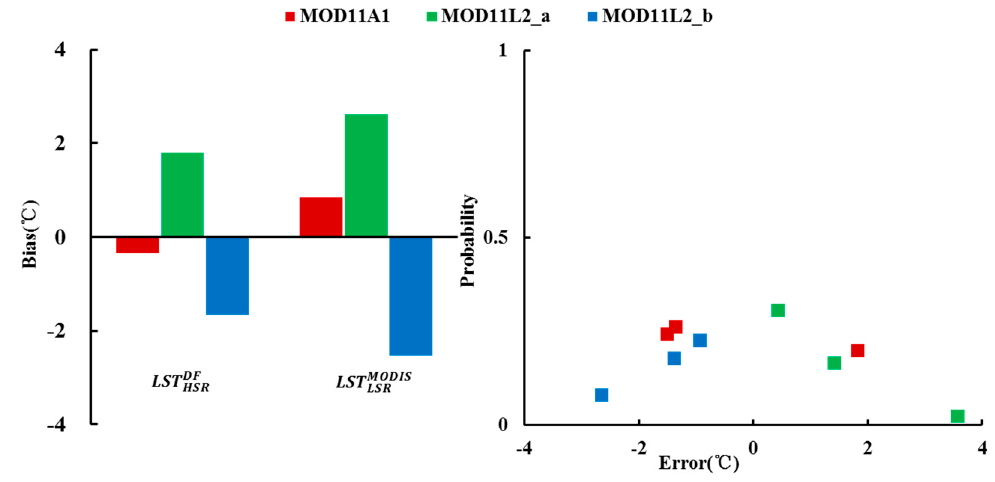
Figure 12. The results of the MODIS LST product and its fused LST compared with in situ observations on 16 July 2017. a: Bias Histogram and, b: fusion error probability distribution.